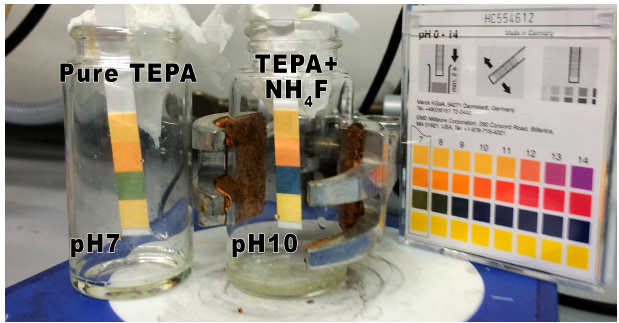
Figure 9. Simple NH 3 detection test with pH paper.